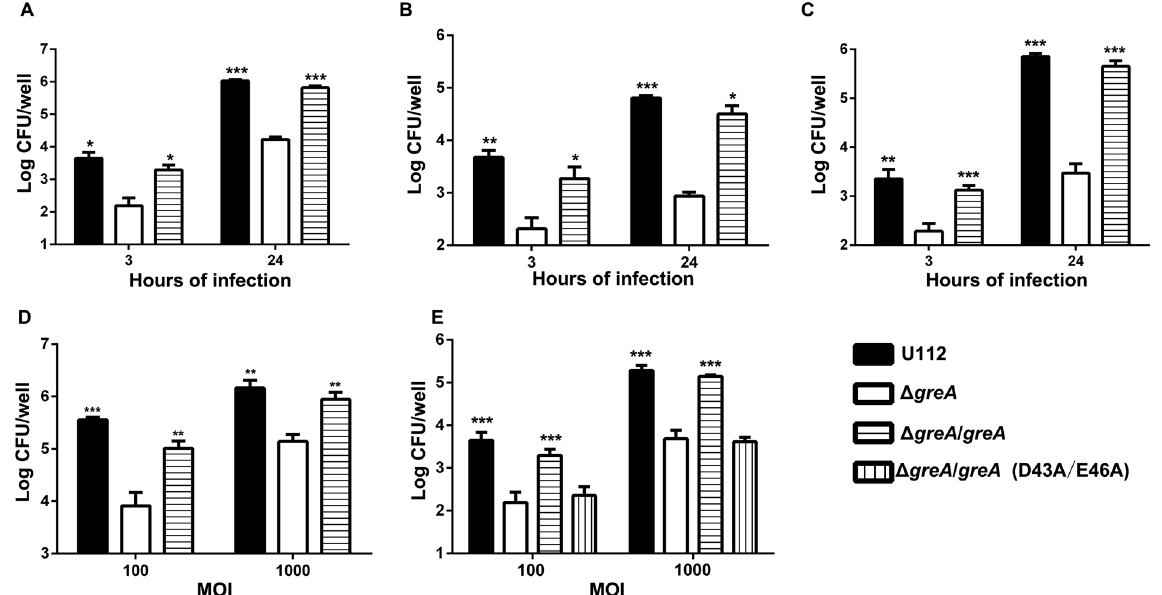
Figure 5. Entry and intracellular growth of wild-type strain U112 and its derivatives. ( A–C ) Intracellular growth of wild-type strain U112 and its derivatives. RAW264.7 ( A ), mouse bone-marrow-derived macrophages ( B ), and A549 ( C ) cell monolayers were infected with the wild-type U112 strain or its derivatives at an MOI of 100:1. At 3 and 24 h post infection, the cells were lysed and plated for enumeration. ( D ) Adhesion of the wild-type U112 strain and its derivatives to RAW264.7 cells. RAW264.7 cells were pretreated with 1 μ g/ml cytochalasin D for 1 h before infection with the wild-type U112 strain or its derivatives at an MOI of 100:1 or 1000:1. After incubation for 2 h, the cells were lysed to enumerate the adherent bacteria CFU. ( E ) Invasion of RAW264.7 cells by the wild-type U112 strain or its derivatives. RAW264.7 cells were infected with the wild-type U112 strain or its derivatives at an MOI of 100:1 or 1000:1 for 2 h, and then treated with 100 μ g/ml